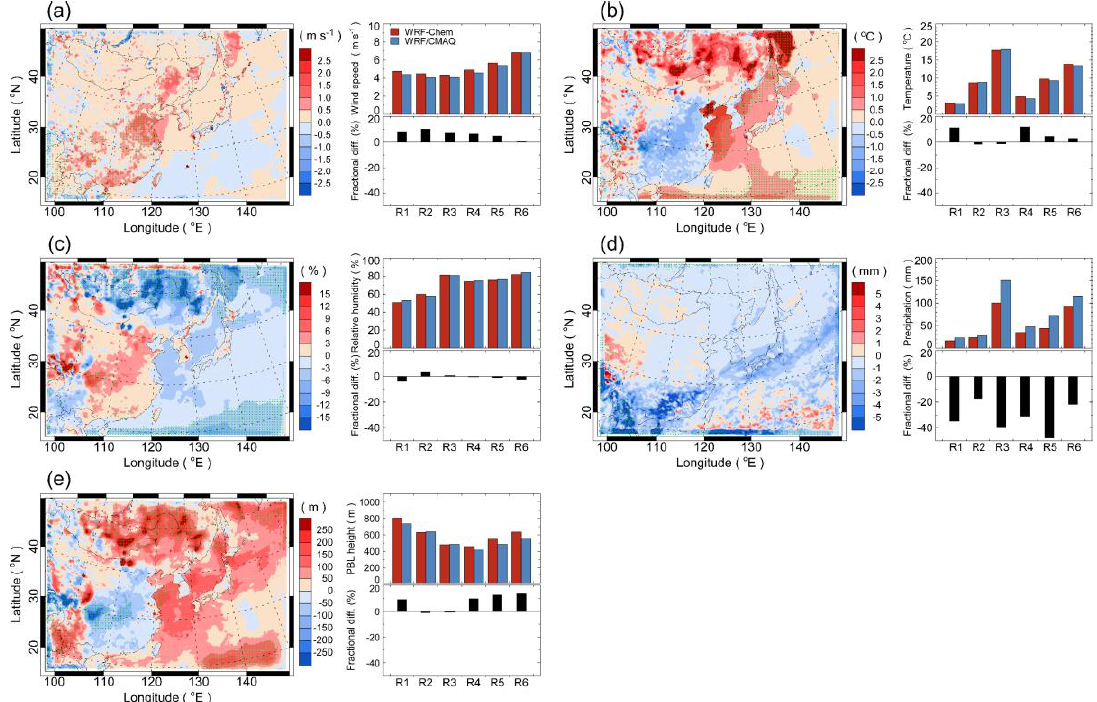
Figure 5. The meteorological differences simulated by the WRF-Chem and WRF/CMAQ models in ( a ) 10-m wind speed, ( b ) 2-m temperature, ( c ) relative humidity, ( d ) precipitation, and ( e ) PBL height. The meteorological differences were calculated by M WRF-Chem – M WRF/CMAQ .